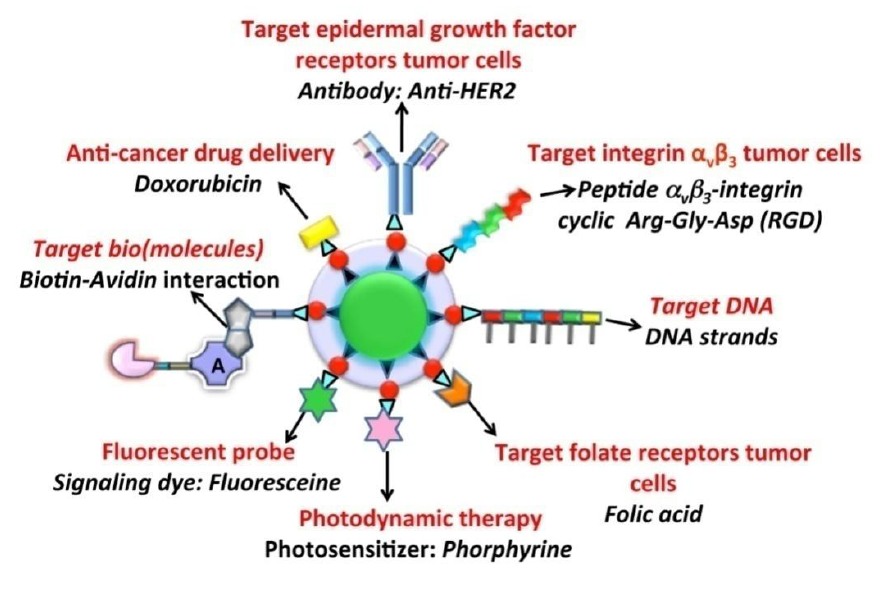
Figure 10. Different functionalization approaches used for UCNPs in order to provide a targeting or therapeutic